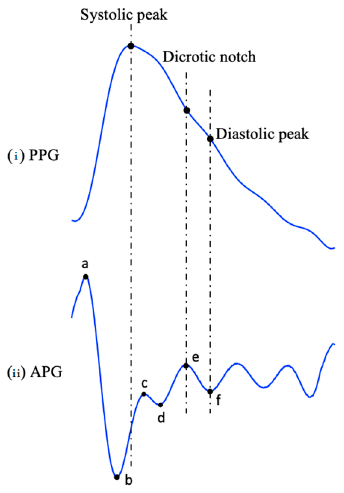
Figure 3. PPG and APG waveforms, ( i ) Filtered PPG waveform, ( ii ) APG waveform, consisting of overall six fiducial points, where four points are in the systolic phase (a–d) which corresponds to the point of maximum acceleration, and two points are in the diastolic phase (e,f) which correspond to the dicrotic notch and diastolic peak of the PPG waveform.